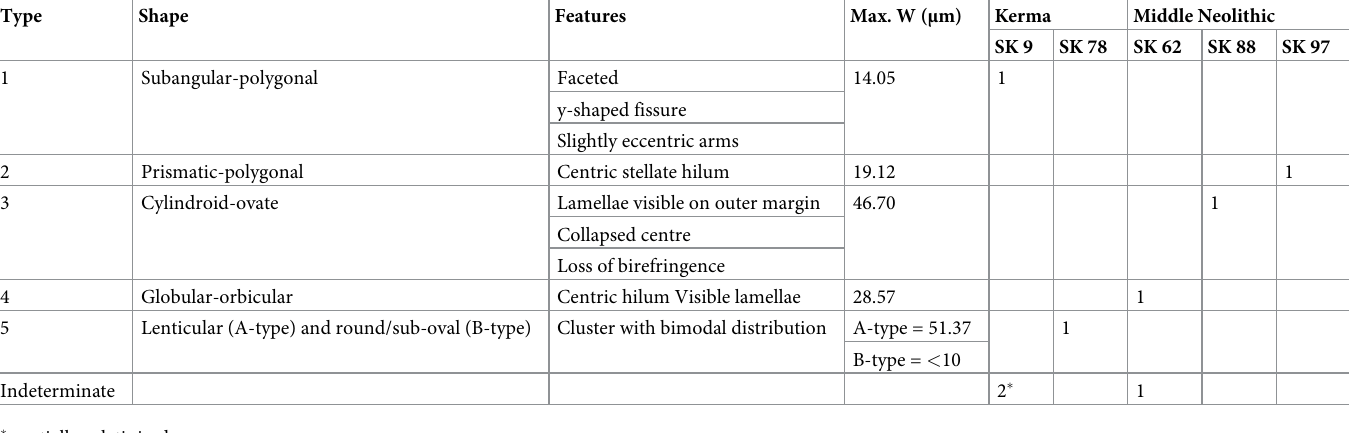
Table 2. Summary of starch granule morphotypes preserved within the dental calculus of KDK1